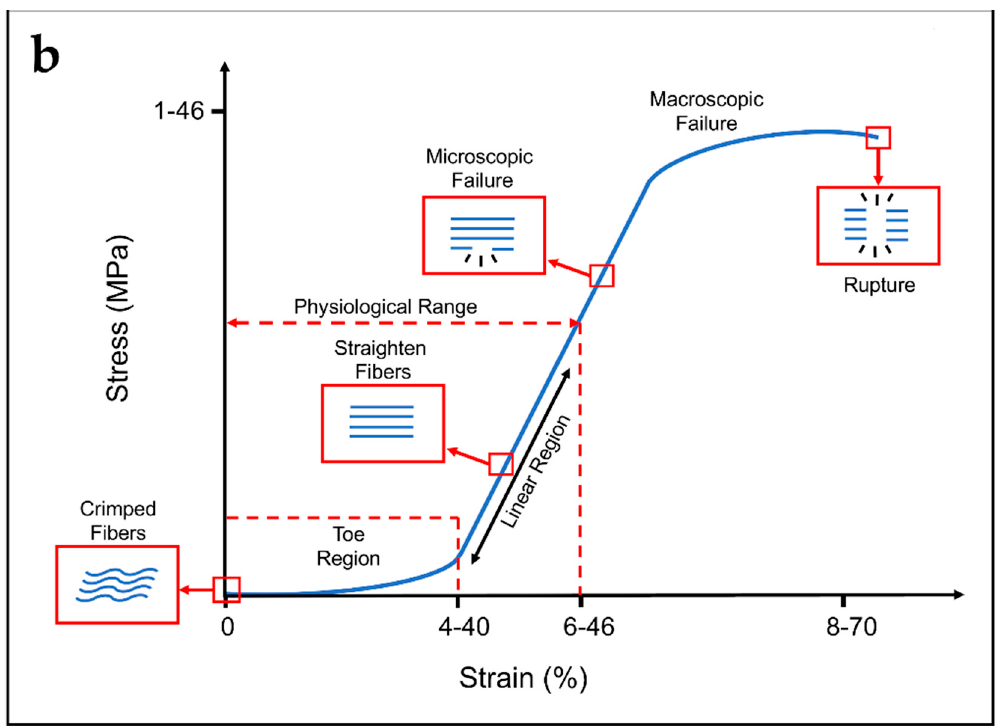
Figure 2. Typical stress–strain curve and schematization of the behavior of the collagen fibers for: ( a ) tendons; and ( b ) ligaments. Typical ranges of stress and strain are indicated on the x and y axes.